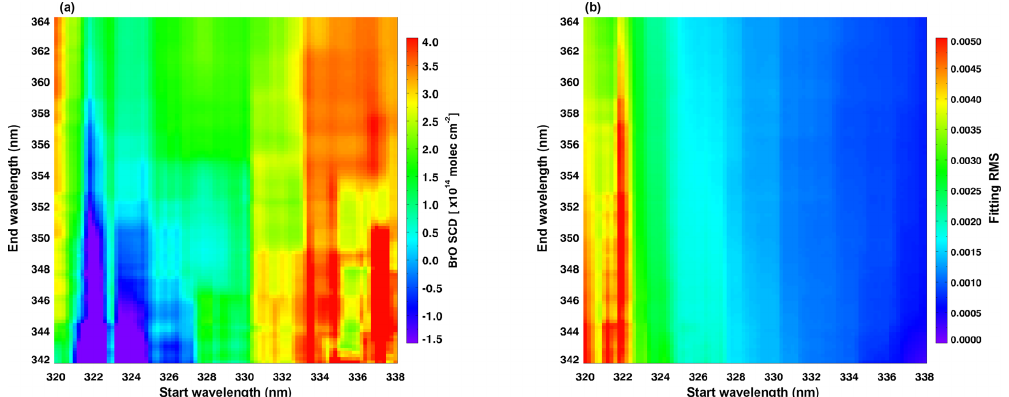
Figure 2. Color-coded means of (a) BrO SCDs and (b) fitting rms values retrieved over the selected Arctic sea ice region for a BrO explosion event using TROPOMI measurements at different wavelength intervals.